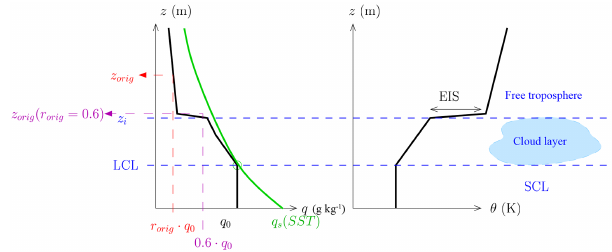
Figure 5. Schematics illustrating the typical structure of tropical marine boundary layers. The sub-cloud layer (SCL) extends from the surface to the lifting condensation level (LCL) and the cloud layer extends from the LCL to the inversion ( z i ). EIS stands for the estimated inversion strength. Left: shape of the vertical profile in q (black) and q s (green). Right: shape of the vertical profile in potential temperature θ , inspired by Wood and Bretherton (2006). The LCL, z orig , z orig ,r , and z i altitudes defined in Sect. 3.4 orig = 0 . 6 are